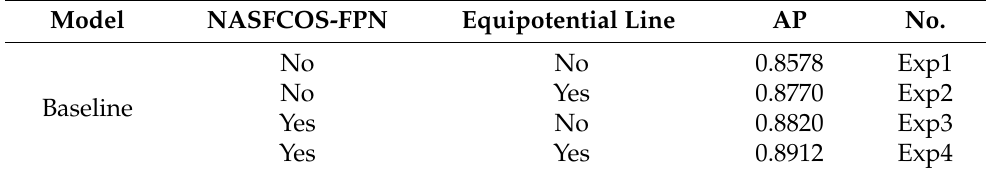
Figure 7. Loss descent curve of CPS-Det. Table 2. Ablation study of CPS-Det on HRSC2016.